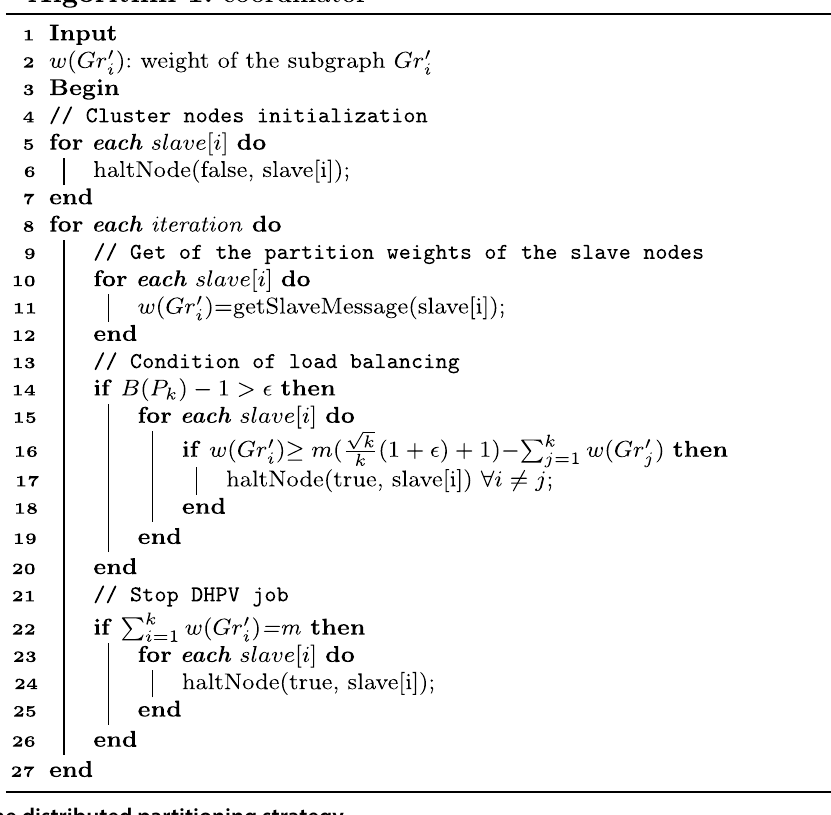
The distributed partitioning